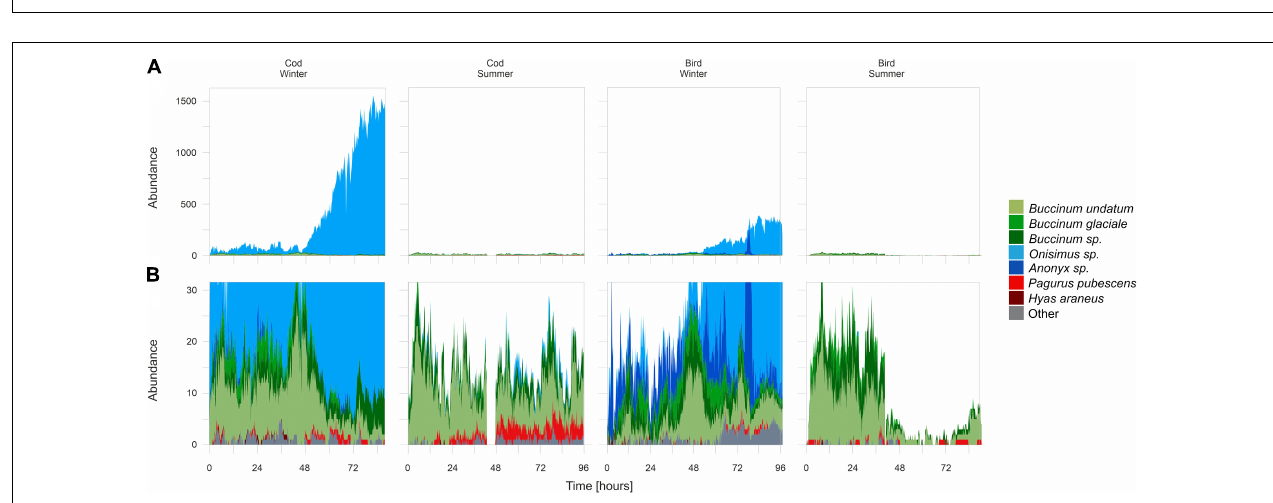
FIGURE 3 | Order of arrival of scavengers at each bait type, for each season.